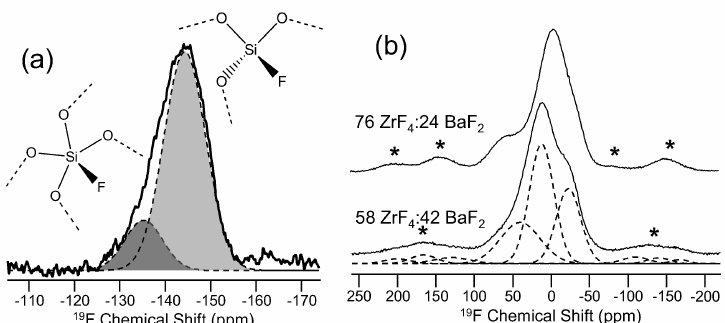
Figure 9. 19 F NMR data for ( a ) F-doped silica [56], with permission from Elsevier, and ( b ) two binary barium fluorozirconate glasses, adapted with permission of Elsevier from [58]. In ( a ), the assignment of the two resonances is depicted in the structure diagrams, where all oxygen atoms are bridging to other silicon atoms (not shown in diagram). Glass compositions and spinning sidebands (asterisks) are shown for ( b ). In both figures, solid lines denote experimental 19 F MAS NMR data, and filled curves or dashed lines represent fitting of the data using Gaussian